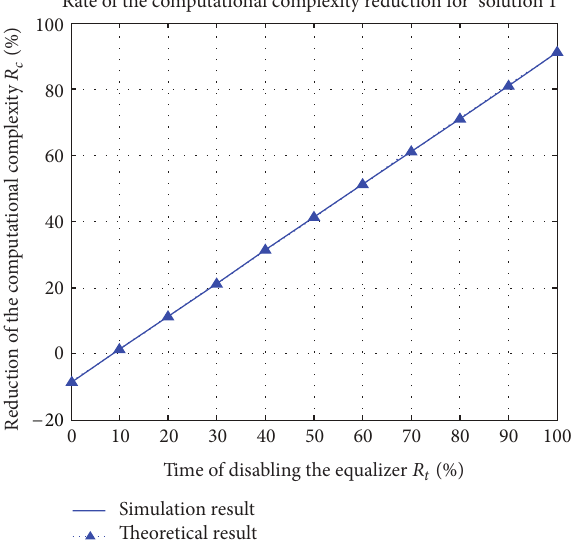
Simulation result Theoretical result